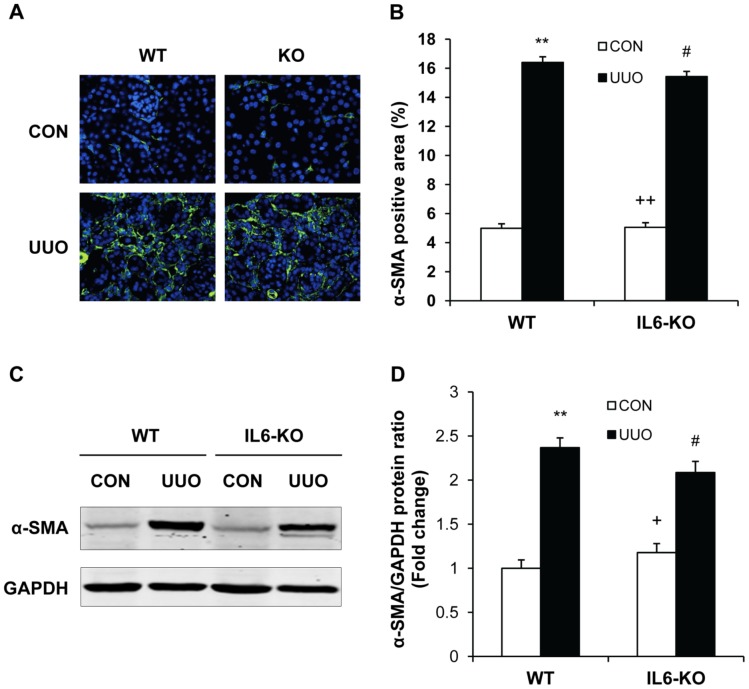
Effect of IL-6 deficiency on myofibroblast activation and α-SMA expression in obstructive nephropathy.
A. Representative photomicrographs of α-SMA immunostaining in the kidney of WT and IL-6 KO mice after UUO. B. Quantitative analysis of α-SMA protein expression in the kidney of WT and IL-6 KO mice after UUO. ** P<0.01 vs WT controls; #
P>0.05 vs WT UUO; ++
P<0.01 vs KO UUO. n = 5 per group. C. Representative Western blots show the levels of α-SMA protein expression in the kidney of WT and IL-6 KO mice. D. Quantitative analysis of α-SMA protein expression in the kidney of WT and IL-6 KO mice. ** P<0.01 vs WT controls; #
P>0.05 vs WT UUO; +
P<0.05 vs KO UUO. n = 3 per group.